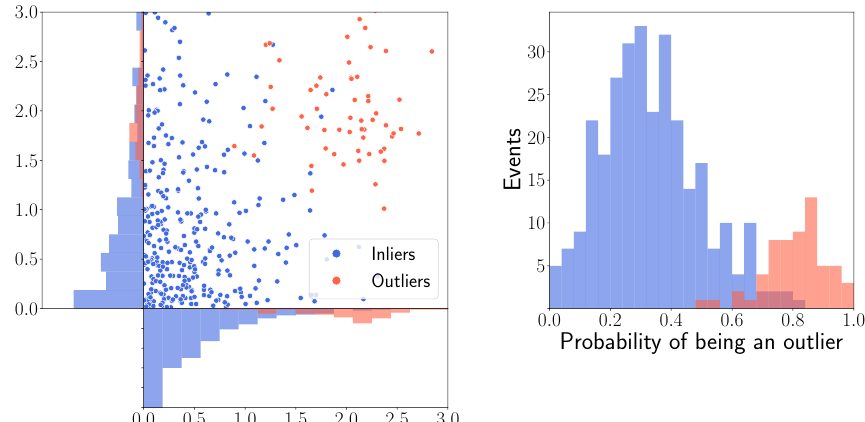
Figure 9: Left: A narrow Gaussian anomaly centered around ( 2,2 ) (in red) is added to an exponentially-distributed background (in blue). Right: The probability of be- longing to the signal events (outliers) is assigned to each point of the dataset and we can perform a counting. In this case, higher probabilities are correctly assigned to the